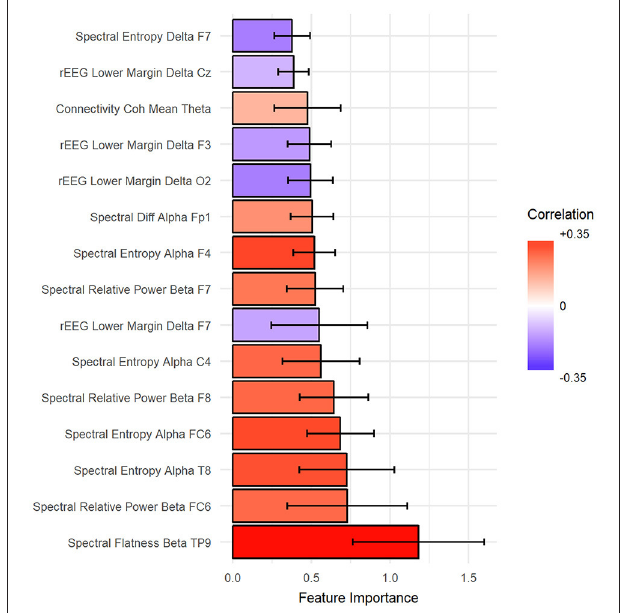
FIGURE 7 | The top 15 important features to predict age sorted from most important (bottom) to top. Ventricle axis shows the scoring values from stack-ensemble model predictor, while the color indicates the correlation values between that feature and age.